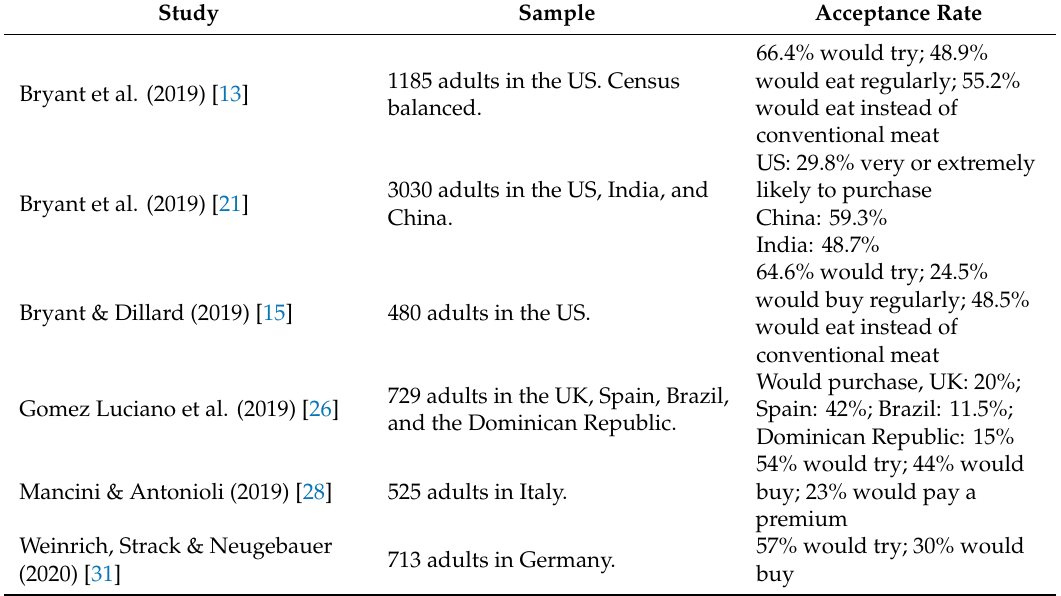
Table 3. Representative surveys of cultured meat